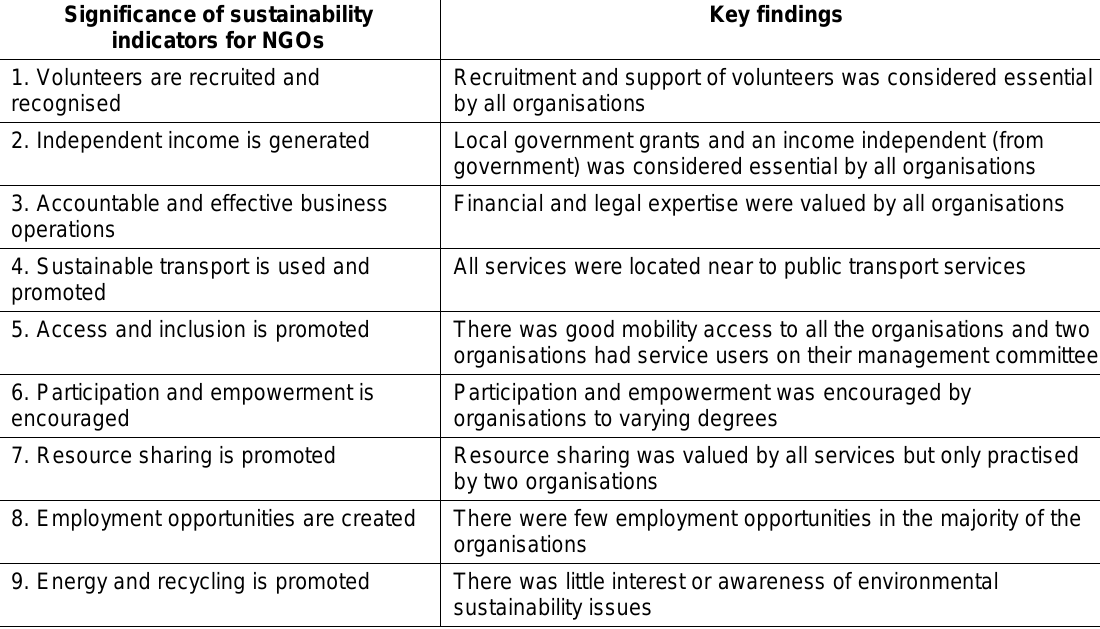
Table 3: Significance of sustainability indicators for NGOs